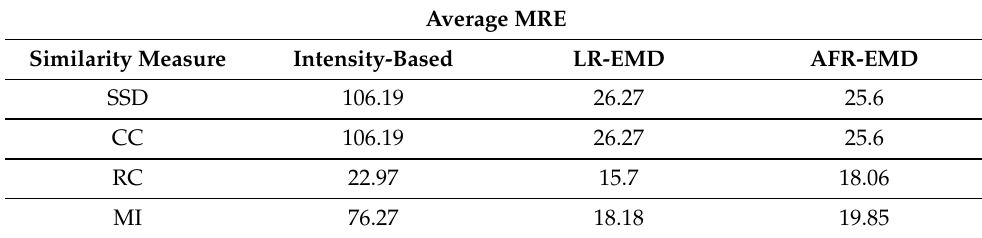
Figure 9. Registration accuracy of different similarity measures in three approaches of intensity-based, LR-EMD, and AFR-EMD. ( A ). SSD, ( B ). CC, ( C ). MI, ( D ). RC. Table 2. Registration performance of different approaches in the application of retina